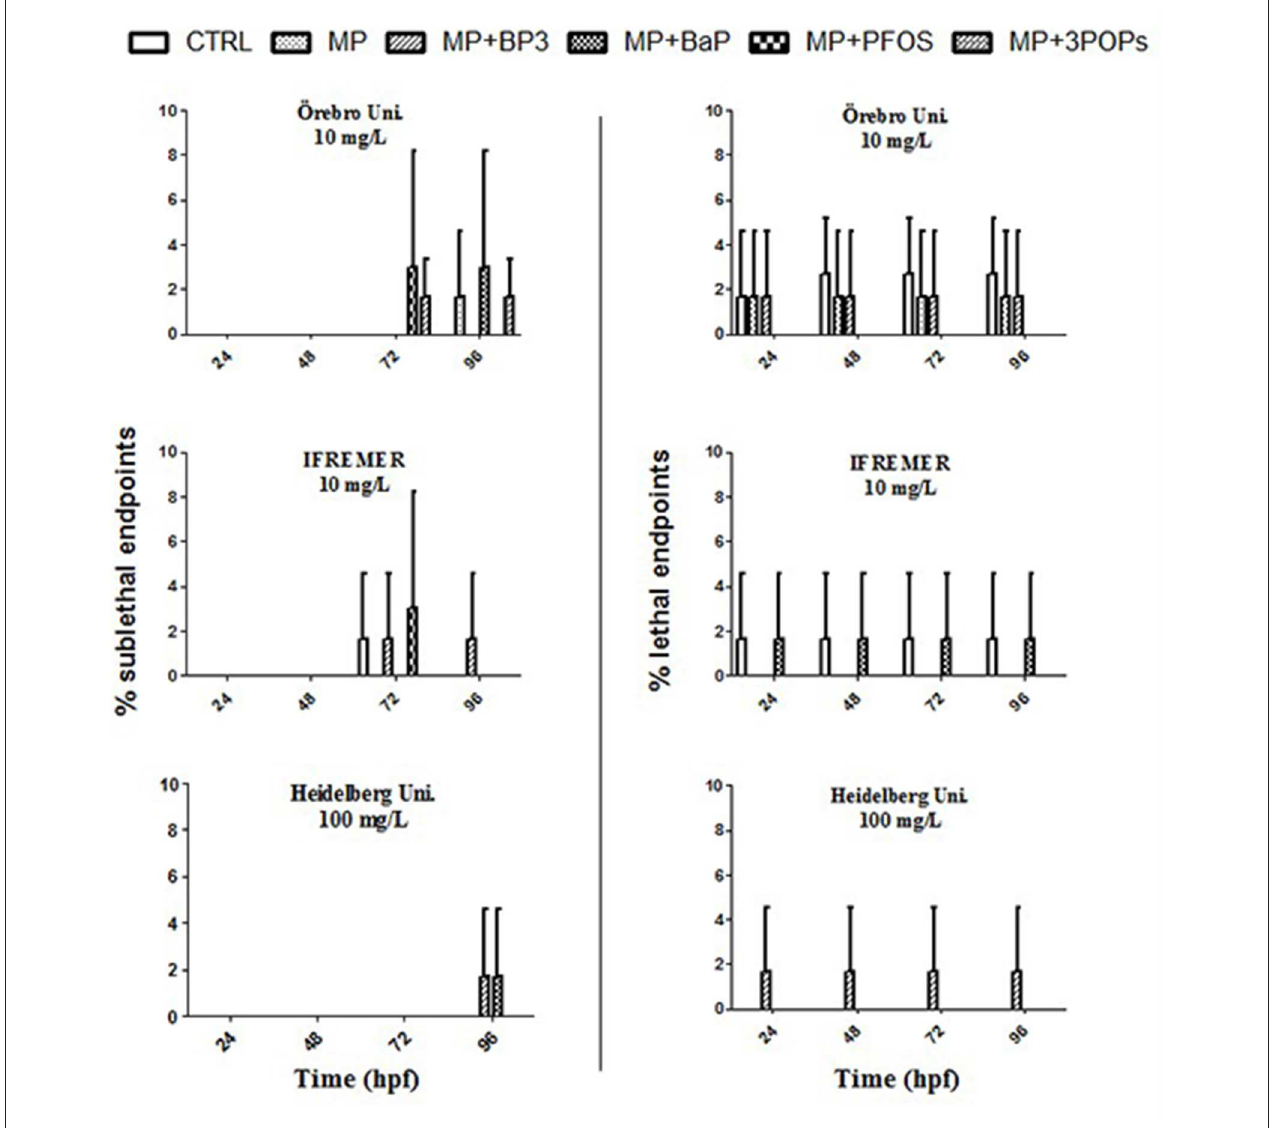
FIGURE 1 | Sublethal and lethal endpoints of zebrafish ( Danio rerio ) embryos after 24, 48, 72, and 96h exposure to microplastics (MP) and microplastics spiked with benzophenone 3 (MP + BP3), benzo(a)pyrene (MP + BaP), perfuorooctane sulfonate (MP + PFOS) as well as a mixture of the three pollutants (MP + 3 POPs) relative to the negative control (CTRL). Endpoints are given as means ± SD from three independent